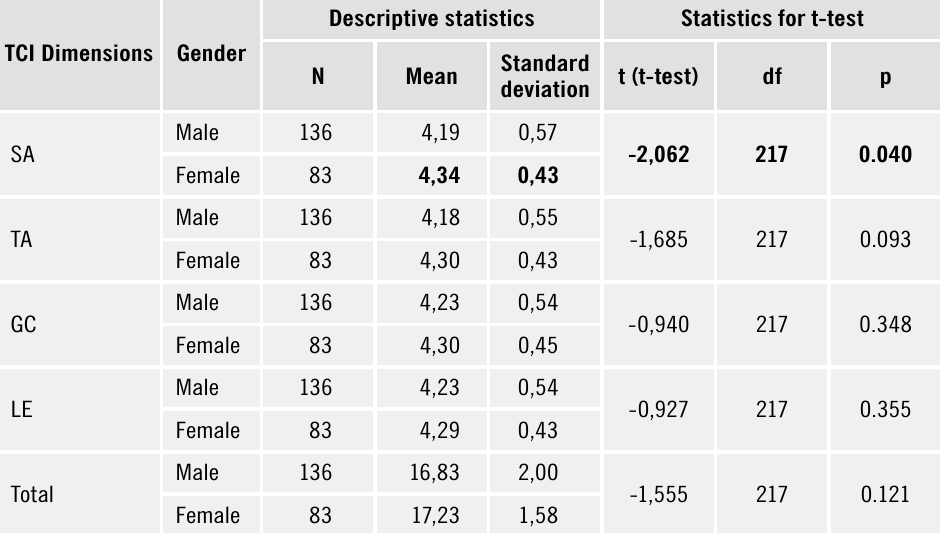
Table 2. Descriptive statistics and the t-test between male and female for the groups from India Descriptive TCI Dimensions Gender